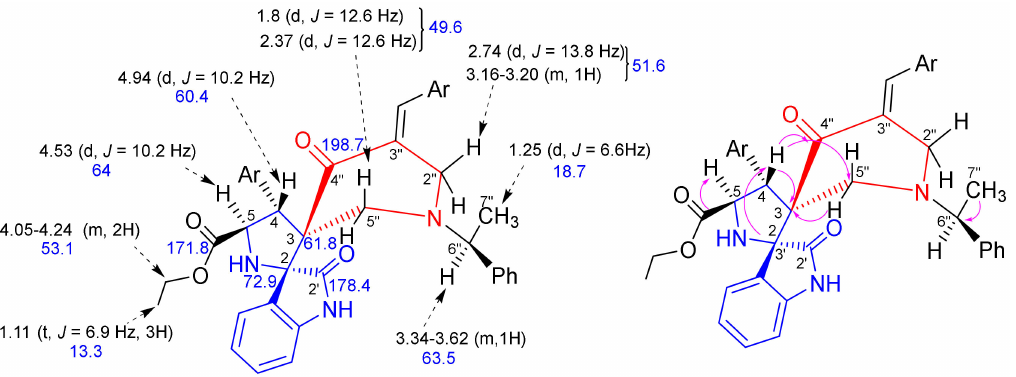
Figure 3. 1 H (black) and 13C NMR (blue) chemical shifts along with selected HMBC correlations of 4c